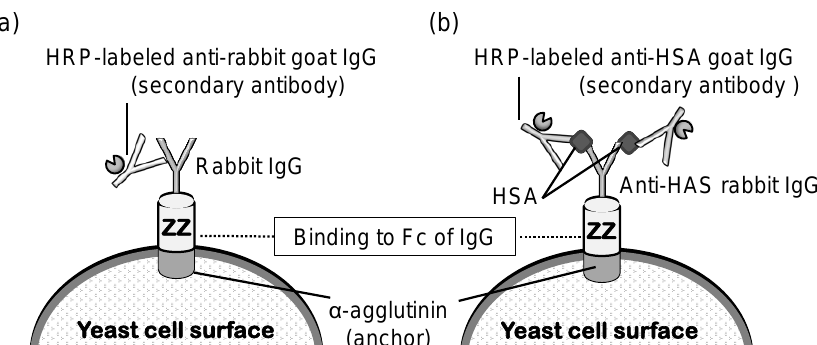
Figure 6. Schematic illustration of ( a ) ELISA to detect rabbit IgG and ( b ) sandwich ELISA to detect HSA using yeast cells displaying ZZ. The first antibody (rabbit IgG) binds to ZZ using its Fc region. HRP Horseradish peroxidase, IgG immunoglobulin G, HSA human serum albumin. The figure was adapted from [119].